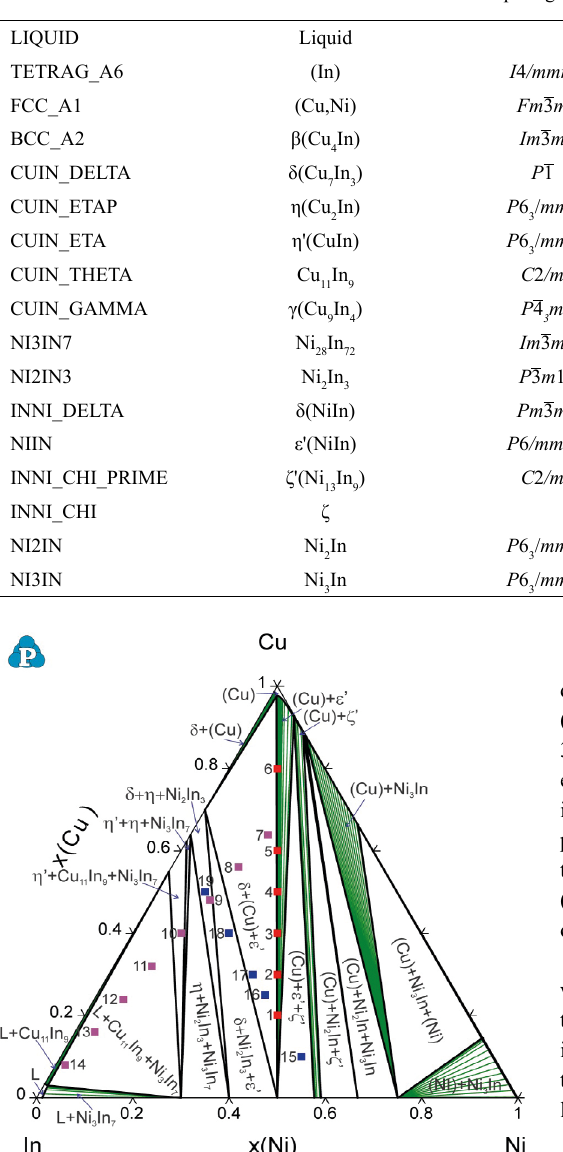
Figure 1. Predicted isothermal section of the ternary Cu-In-Ni system at 300 ºC with marked compositions of the studied samples be observed in Fig.2e and Fig.2f as the dark phase trapped between intermetallic compounds. The intermetallic compound Cu In appears as the darkest phase in the microstructures 11 9 of the alloy samples 11 and 12 while the Ni compound is the most abundant phase. with lattice parameters from literature 23-30 . Two XRD patterns with identified phases, one for the sample 1 and the other for the sample 15 are shown in Figure 3, as an